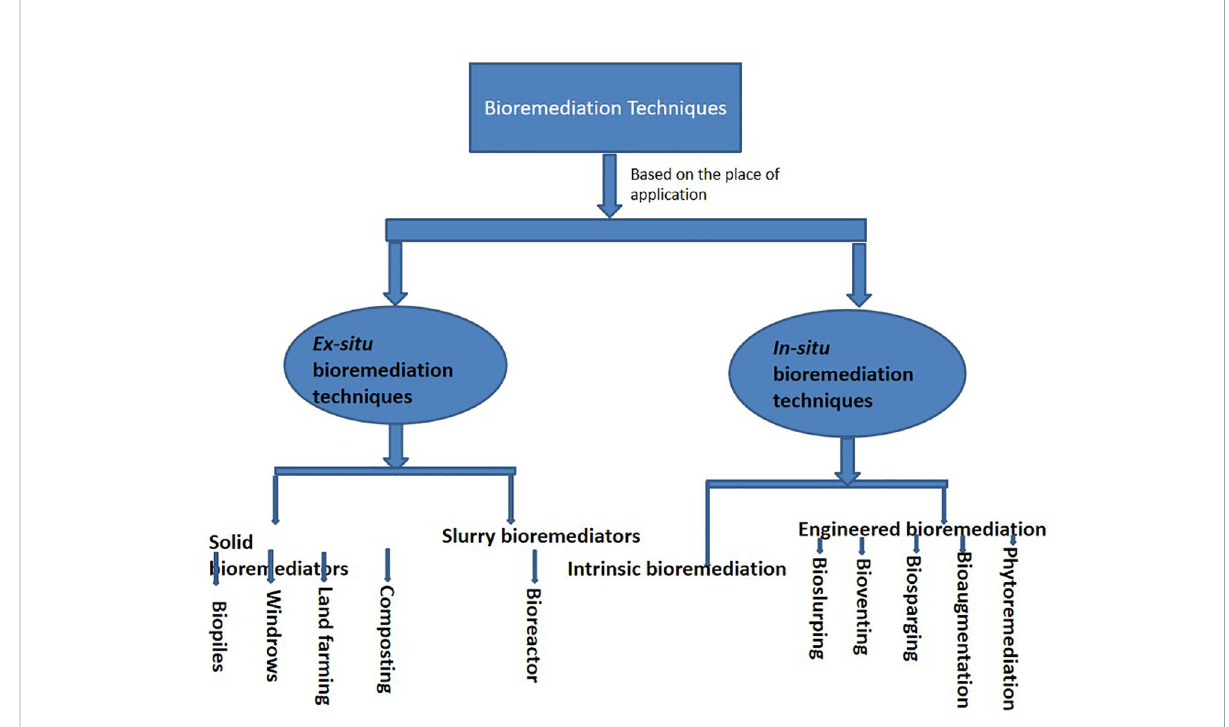
FIGURE 1 Bioremediation